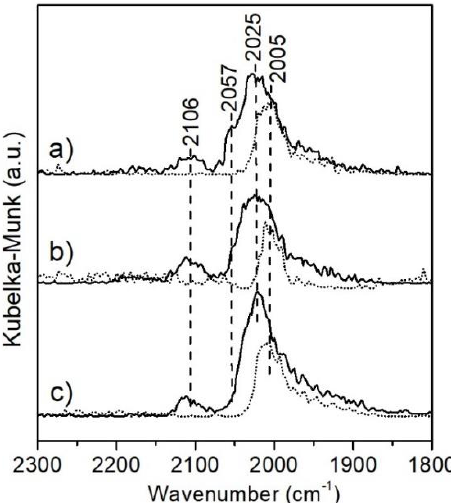
Figure 7. Diffuse Reflectance Infrared Fourier Transform (DRIFT) spectra of CO adsorbed on the reduced catalysts at ambient temperature. Solid: equilibrium pressure of 50 Pa CO; dash: after evacuation. Catalysts: Ni/Cu/ZnO/Al 2 O 3 -OA, ( a ) Ni/Cu/Zn/Al (molar) = 5/32.5/32.5/30, ( b ) Ni/Cu/Zn/Al (molar) = 1/34.5/34.5/30, ( c ) Cu/Zn/Al (molar) = 35/35/30. All traces have been displaced for clarity.